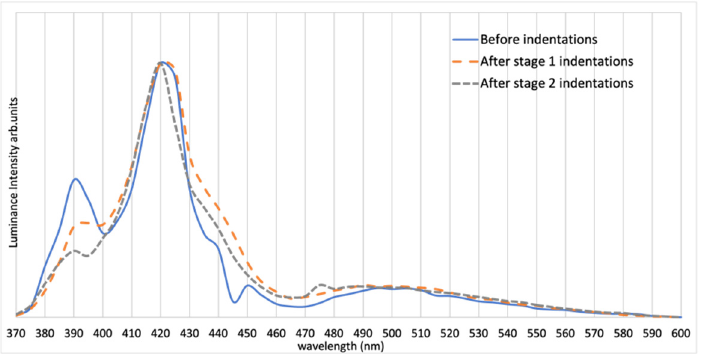
Figure 8. Spectrum of Sample 3 before and after indentation at each stage (normalized at highest peak). Table 3. PV reading and intensity ratio of Samples 2 and